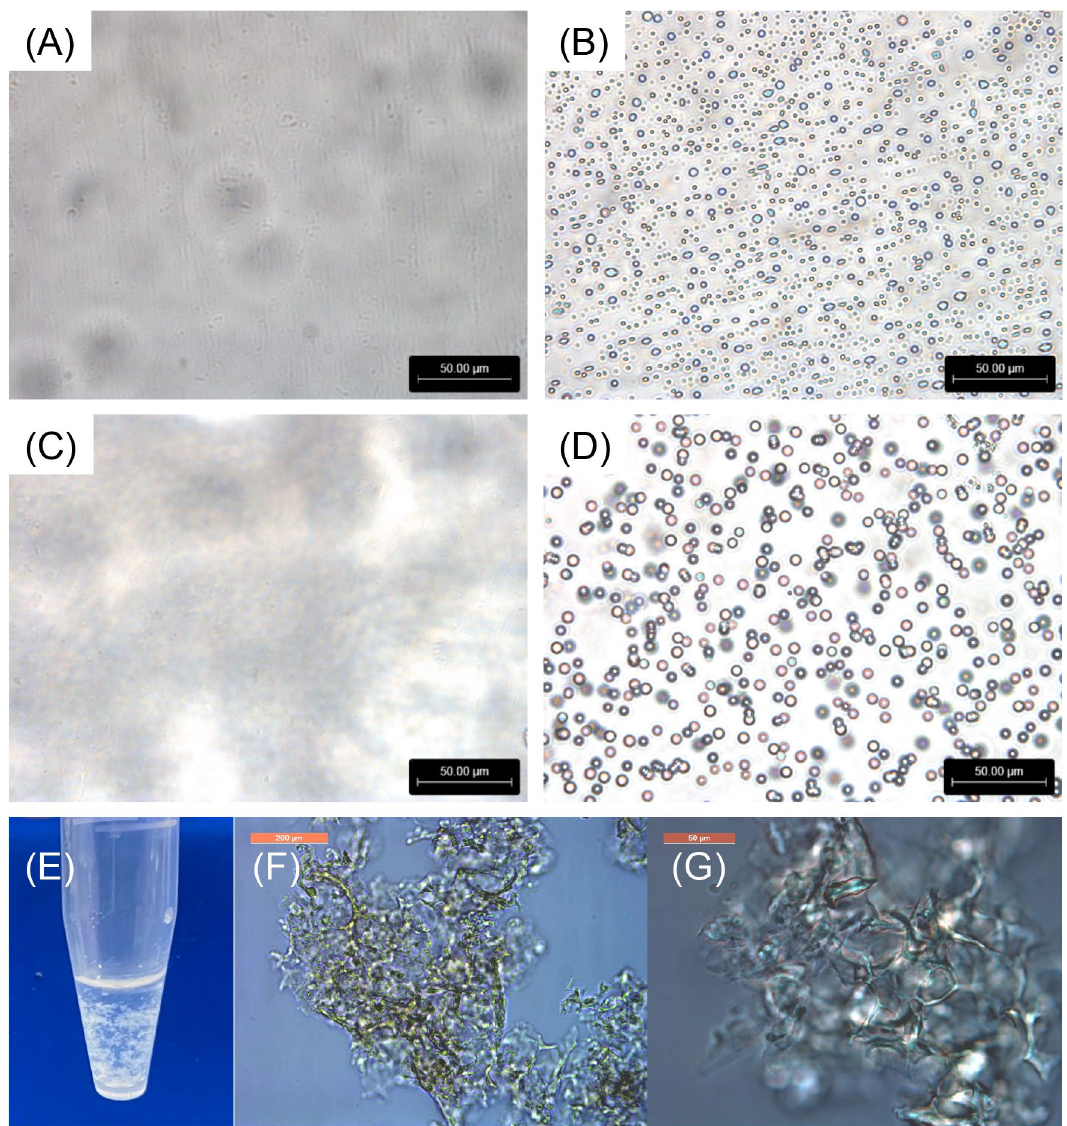
Figure 6. Morphological studies of the truncated elastin-like peptide (ELP) analogues. Optical microscopy images of the truncated ELPs dissolved in phosphate buffer (27.4 mM Na 2 HPO 4 , 17.8 mM NaH 2 PO 4 , pH 7.4) at a concentration of 10 mg/mL. Microscopy images of ( A ) (FPGVG) 4 (5 °C, × 40), ( B ) (FPGVG) 4 (40 °C, × 40), ( C ) (FPGV) 4 (5 °C, × 40), and ( D ) (FPGV) 4 (25 °C, × 40). ( E ) Image of (FPG) 4 irreversible aggregates formed in a phosphate buffer solution. Microscopy images of ( F ) (FPG) 4 (× 10) and ( G ) (FPG) 4 (× 40) are also shown. Scale bars: 50 μm in ( A )–( D ) and ( G ), and 200 μm in ( F